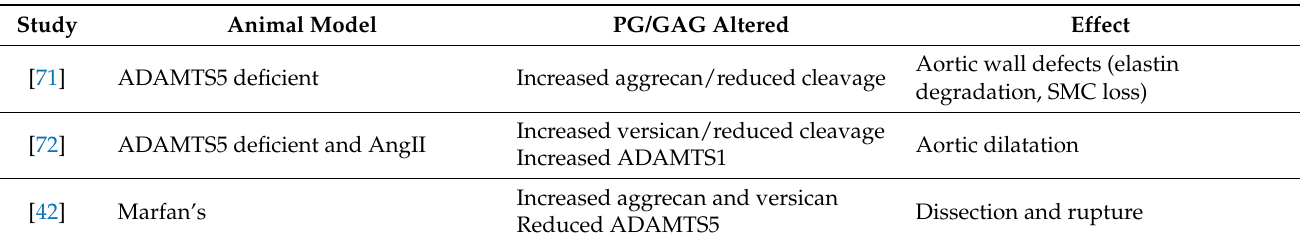
Table 4. Animal studies associated with PG/GAG changes. Model, observations of altered PGs/GAGs and their effect on aortic pathology and integrity are summarised. Smooth